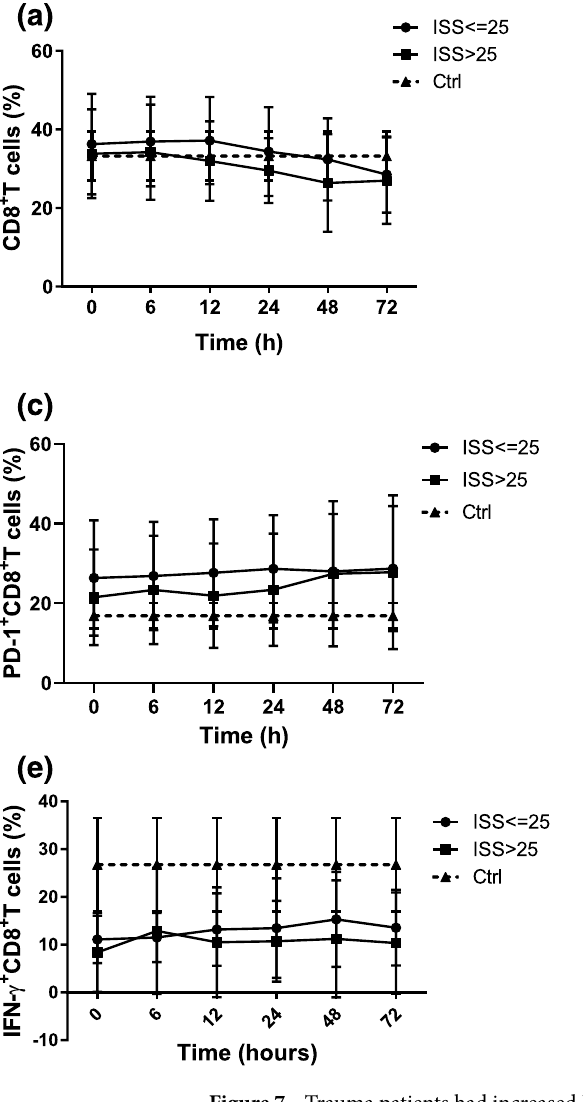
Figure 7. Trauma patients had increased PD1 expression on CD8+ T cells and reduced IFN-γ production by CD8+ T cells as compared to control group. ( a ) CD8+ T cells in trauma patients grouped by ISS. ( b ) The patients with a long ICU stay had an increased CD8+ T cells compared to those with a short ICU stay. ( c ) The expression of PD1 on CD8+ T cells in trauma patients grouped by ISS. ( d ) The patients with a long ICU stay had a higher expression of PD1 on CD8+ T cells compared to those with a short ICU stay. ( e,f ) IFN-γ production by CD8+ T cells in trauma patients grouped by ISS and ICU stay, * p <